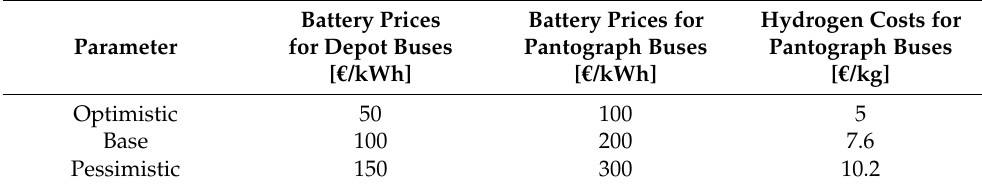
Table 13. Sensitivity analysis of battery prices for e-buses and hydrogen costs for fuel cell bus in 2030 results.